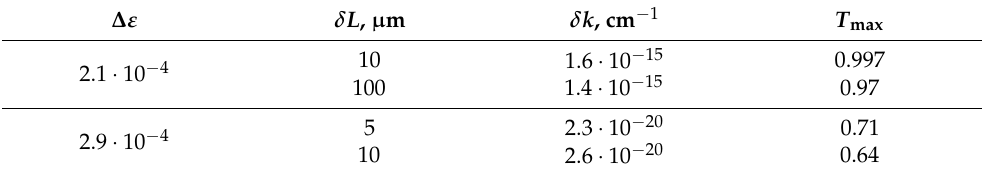
Table 2. The widths of transmission curves δ k amplitudes of transmission coefficients T max